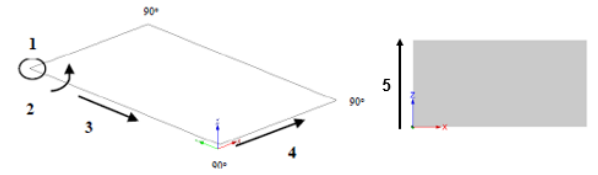
Figure 3. Step sequence for flat roof type geometry